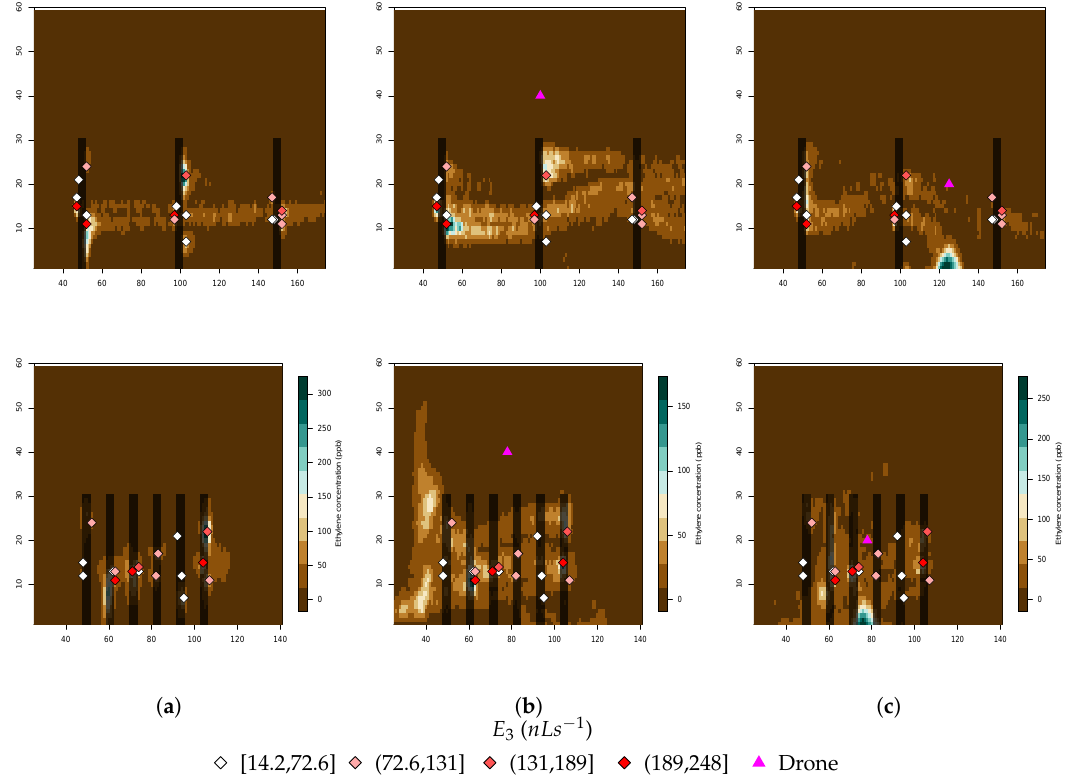
Figure 11. Maximum ethylene concentration in the xz -plane (top plots) and yz -plane (bottom plots) for the drone simulations in the climacteric stage: ( a ) omitting rotor wind flow; ( b ) Drone Position 1; and ( c ) Drone Position 2. The ethylene sources’ position and emission rate are also provided at the